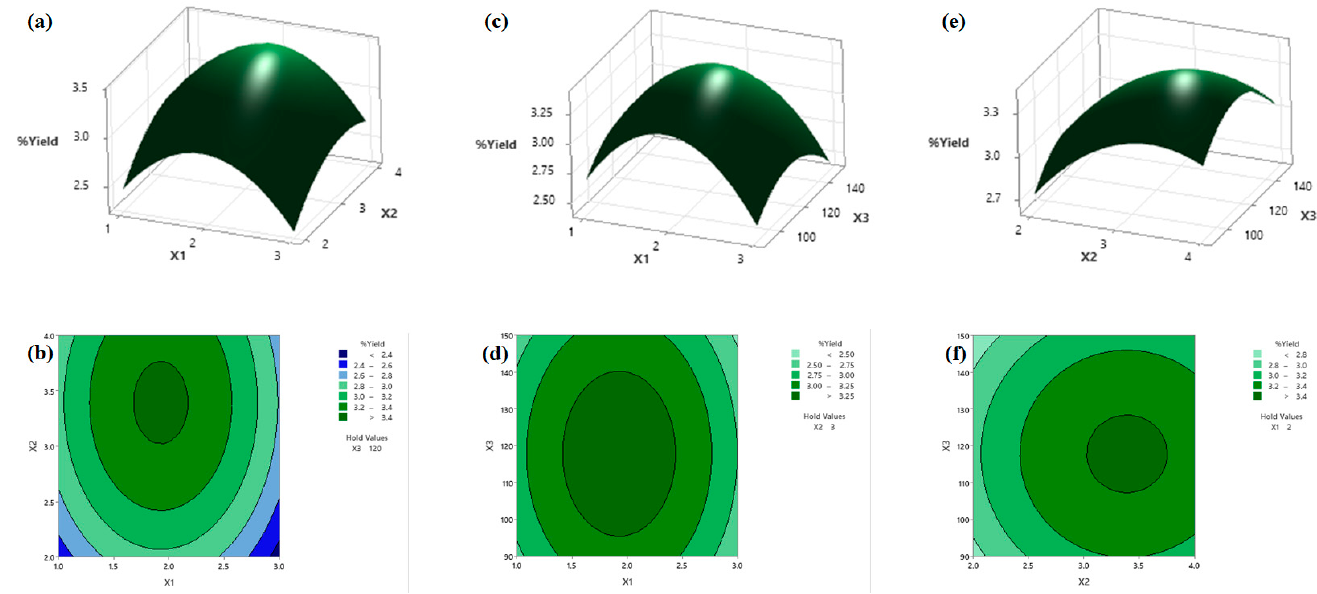
Figure 4. Response surface ( a , c , e ) and contour plots ( b , d , f ) as a function of independent variables on the extraction yield. ( a , b ) NaCl concentration and liquid-to-solid ratio, ( c , d ) NaCl concentration and stirring time, ( e , f ) stirring time and liquid-to-solid ratio. X 1 , X 2 , and X 3 represent the NaCl con- centration, liquid-to-solid ratio, and stirring time, respectively.